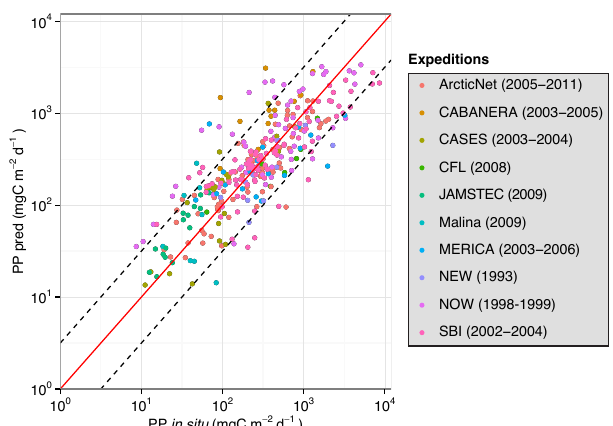
Fig. A1. Scatterplots of algorithm-derived PP versus in situ PP mea- surements. Solid line represents perfect agreement, and dashed lines represent factor of 2 relative